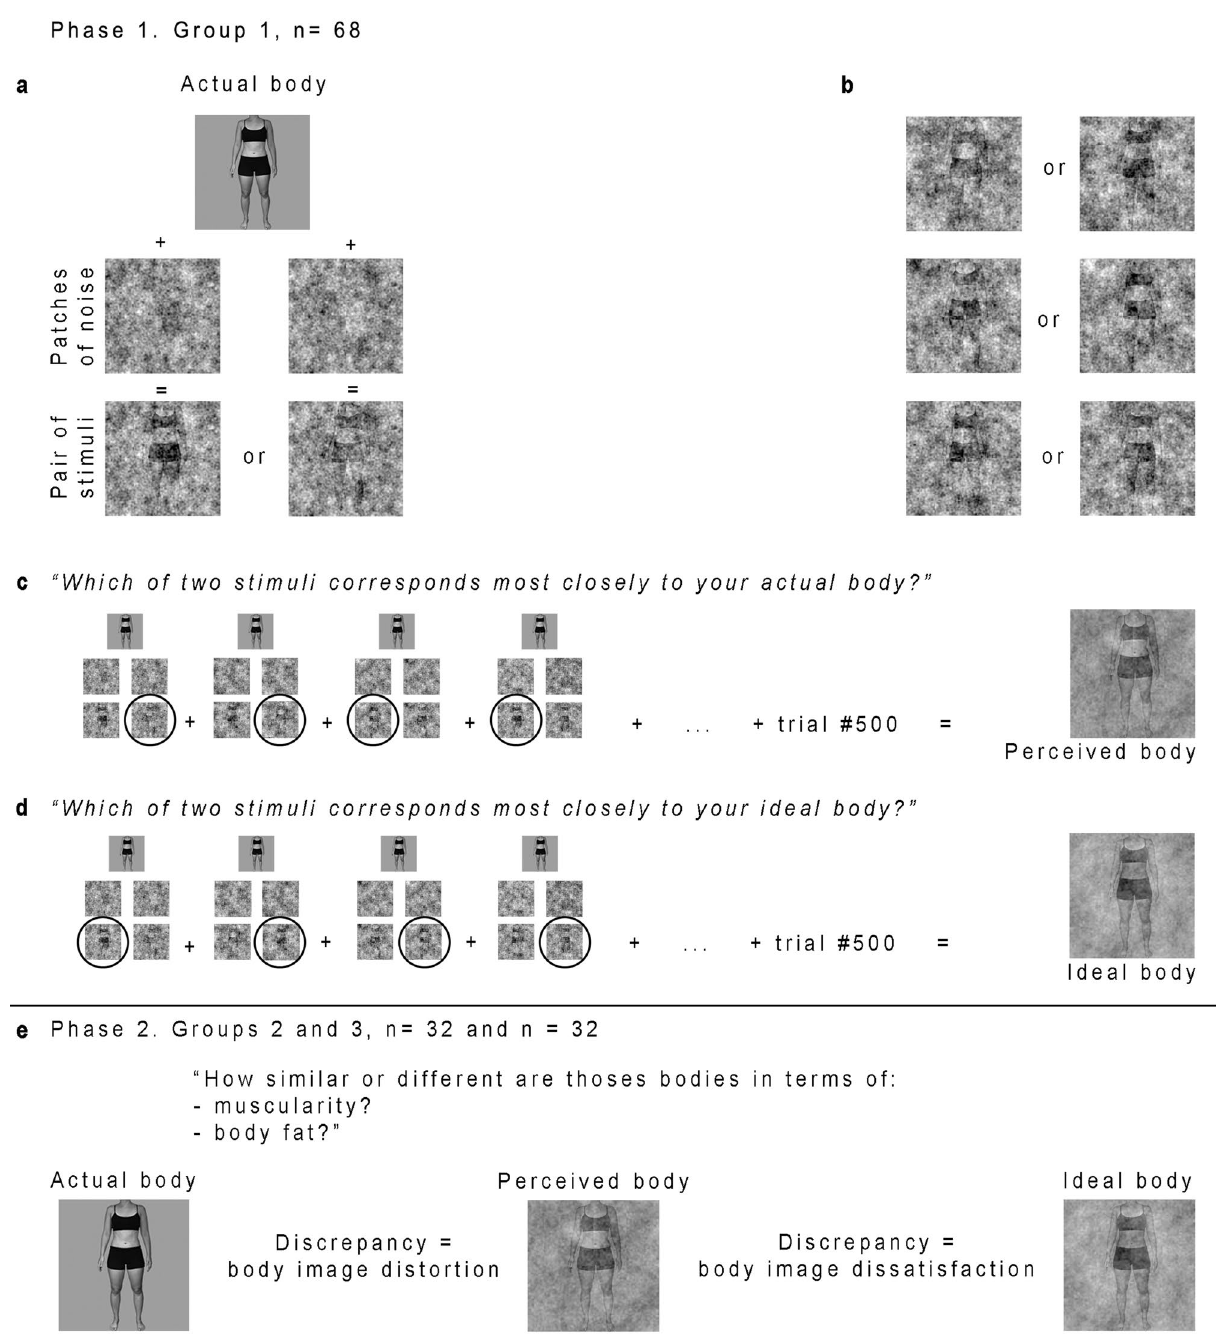
Figure 1. Reverse correlation method to measure body image dissatisfaction and distortion. (a) Example of the steps involved in the creation of a pair of stimuli in the image-construction phase using a participant’s photograph. (b) Examples of stimuli generated through the reverse correlation technique in the image- construction phase for this participant. Patches of visual noise added to her photograph randomly modulates her body’s appearance. (c) Example of trials in the first task (perceived body image). The two stimuli created on a given trial were presented side-by-side to the participant. The images selected by the participant in each of the 500 trials were averaged to produce her perceived body image representation. (d) Example of trials in the second task (ideal body image). (e) Example of comparisons by two new groups of independent participants during phase 2 to assess body image distortion and dissatisfaction of participants tested during phase